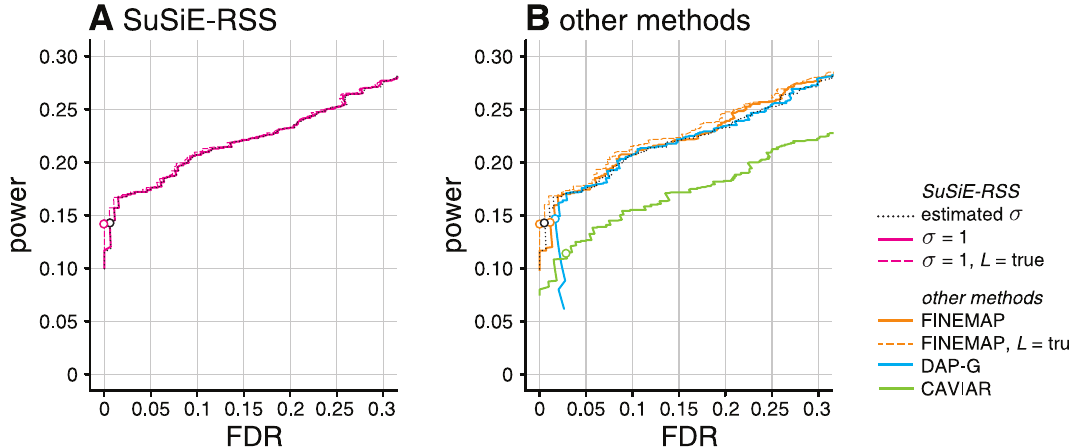
Fig 3. Discovery of causal SNPs using posterior inclusion probabilities—in-sample LD. Each curve shows power vs. FDR in identifying causal SNPs when the method ( SuSiE-RSS , FINEMAP, DAP-G or CAVIAR) was provided with the in-sample LD matrix. FDR and power are calculated from 600 simulations as the PIP threshold is varied from 0 to 1. Open circles are drawn at a PIP threshold of 0.95. Two variants of FINEMAP and three variants of SuSiE-RSS are also compared: when L , the maximum number of estimated causal SNPs, is the true number of causal SNPs, or larger than the true number; and, for SuSiE-RSS only, when the residual variance σ 2 is estimated (“sufficient data”) or fixed to 1 (“summary data”); see Table 1. The results for SuSiE-RSS with estimated σ 2 is shown in both A and B to aid in comparing results. Note that power and FDR are virtually identical for all three variants of SuSiE-RSS so the three curves almost completely overlap in Panel